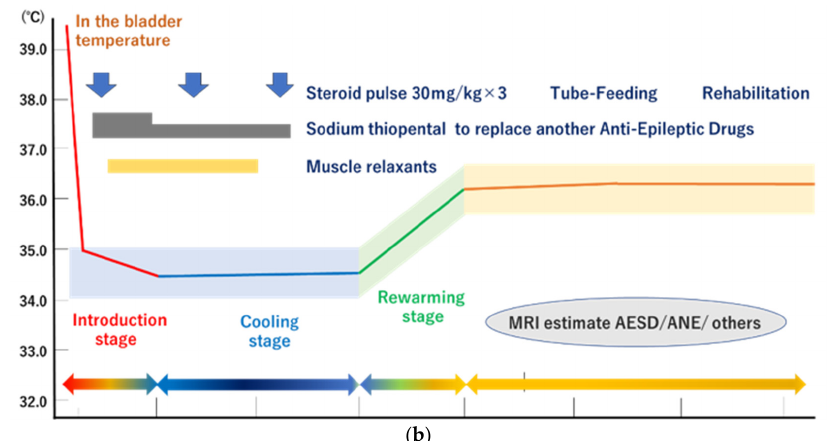
Figure 1. ( a ) Process for mild-brain hypothermia therapy with steroid pulse therapy [24]. ( b ) Pro- cedure from mild-brain hypothermia therapy to targeted temperature management. AESD: Acute encephalopathy with biphasic seizures and late reduced diffusion; ANE: Acute necrotizing en- cephalopathy. 6. Evidence of Therapeutic Hypothermia in Acute Encephalopathy Clinical studies highlight the efficacy of BHT for pediatric acute